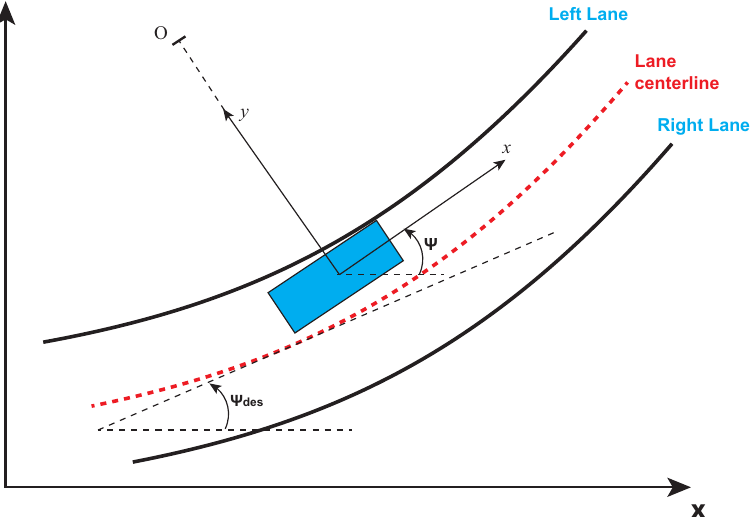
Figure 7. Road representation used in lateral control, highlighting the lane centerline, and the left and right lanes.